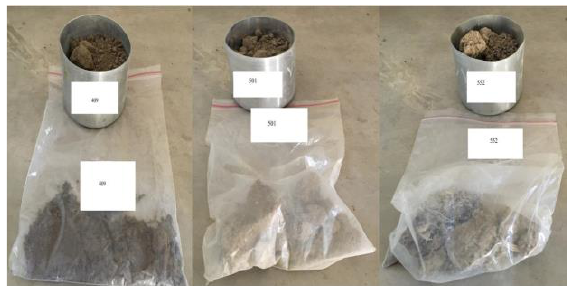
Figure 4. Gravimetric soil water content sampling Station No.